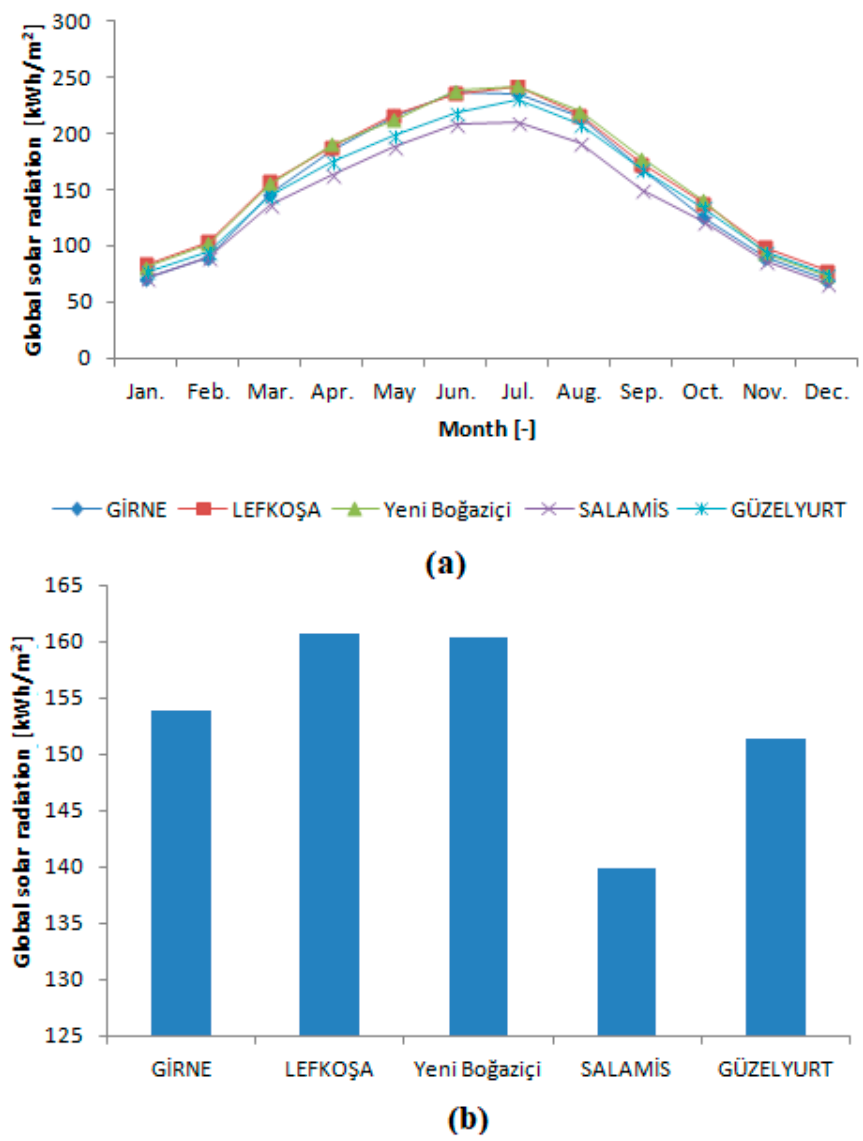
Figure 6. Global solar radiation: (a) mean monthly data and (b) annual data for whole years.